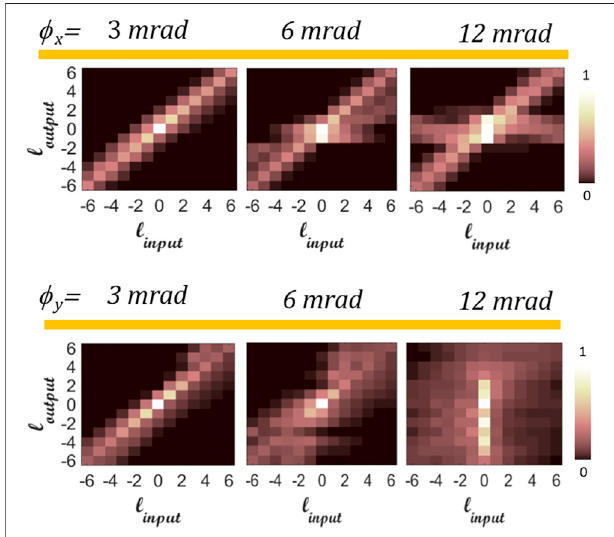
FIGURE10| Calculatedcross-talkmatrixfor13modes,astheincoming modes propagate off-axis to the mode-sorter center. Each case describes modes that propagate with an additional linear phase gradient